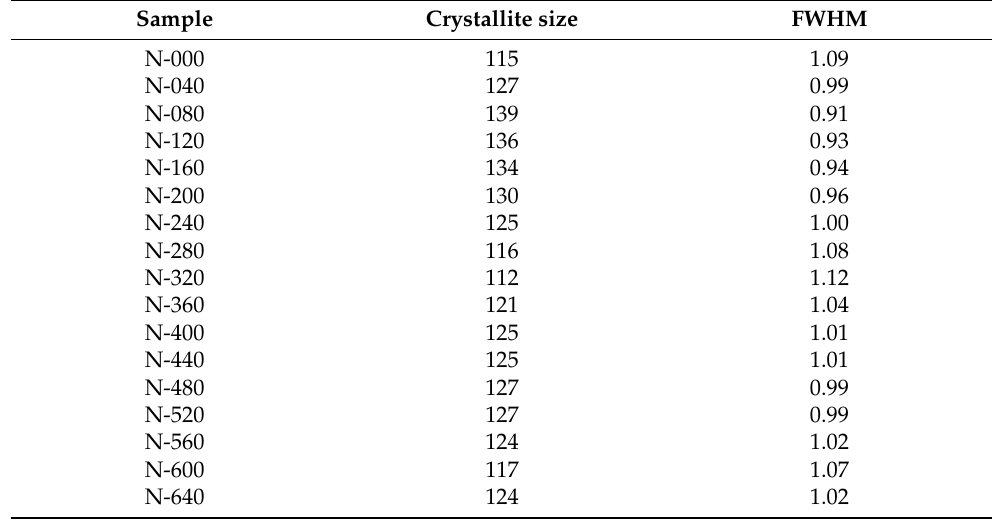
Table A1. Goethite crystallite size obtained from Rietveld refinement and calculated full width at half maximum values